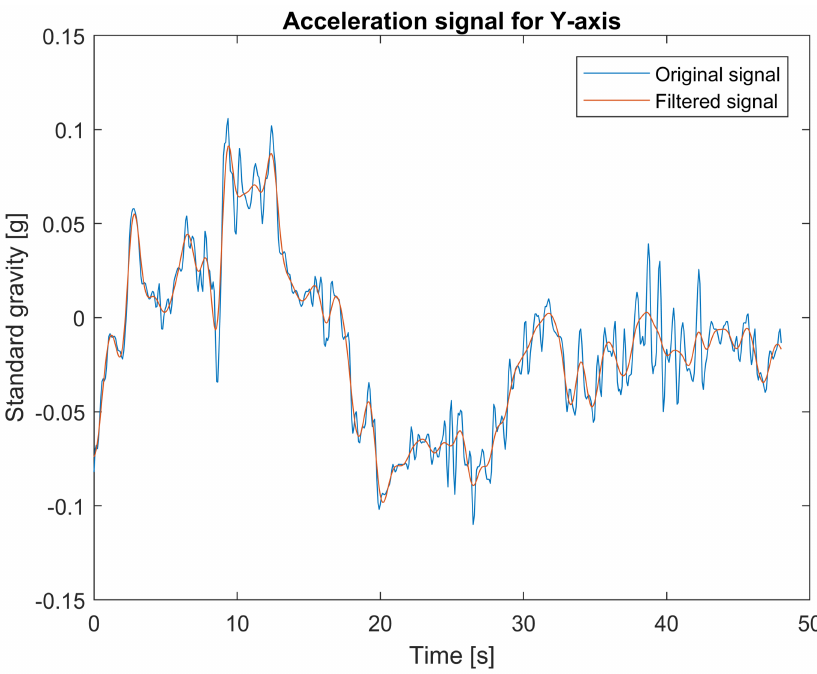
Figure 4. Original and filtered acceleration signal for y